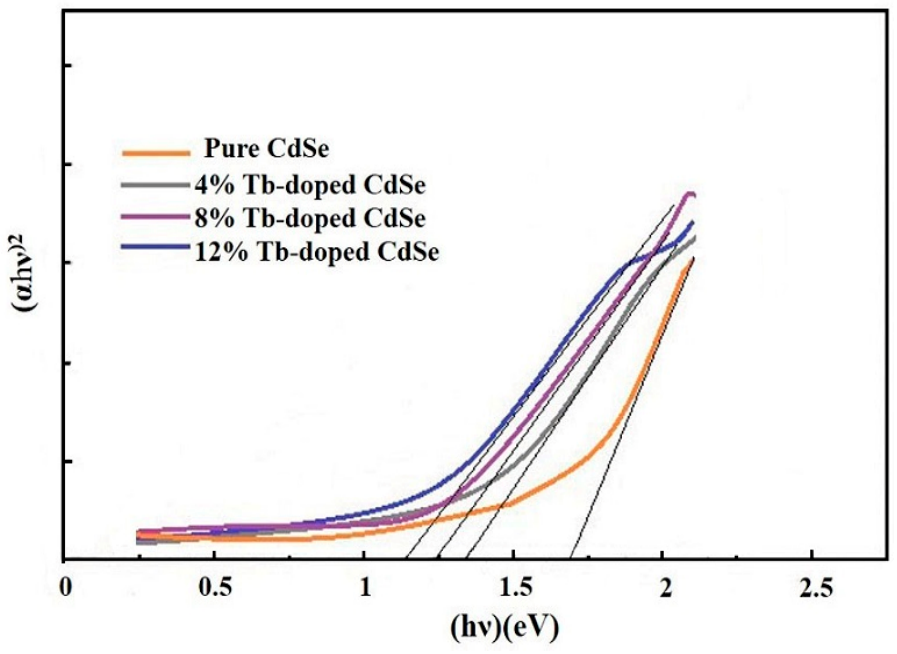
Figure 7. The (A hv ) 2 – hv curves of the Tb-doped CdSe and undoped nanostructures. Table 4. The band gap energy of Tb-doped CdSe and undoped CdSe nanostructures.